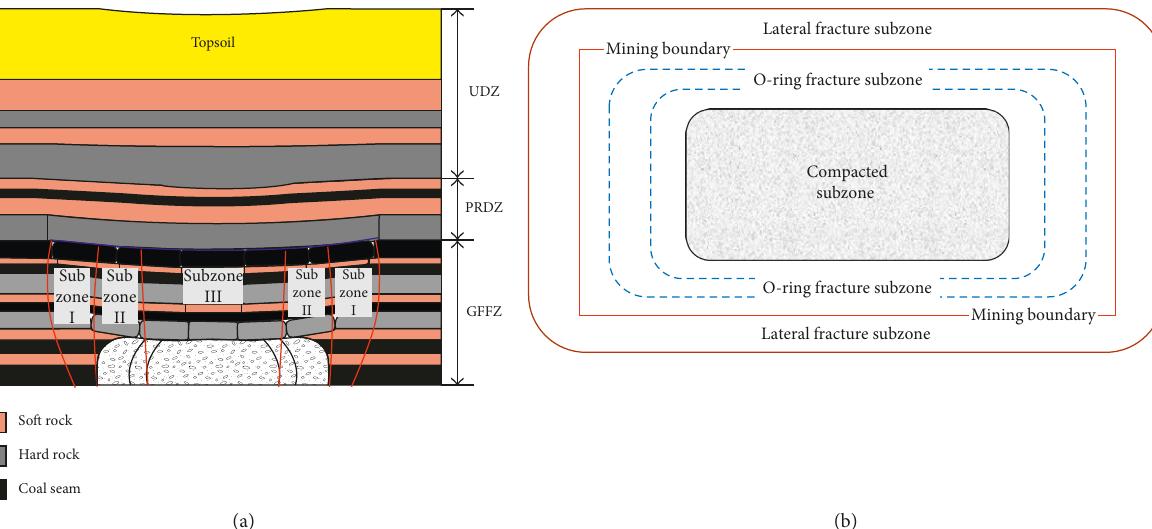
Figure 3: Horizontal subzones of a GFFZ above the gob: (a) vertical profile; (b) horizontal